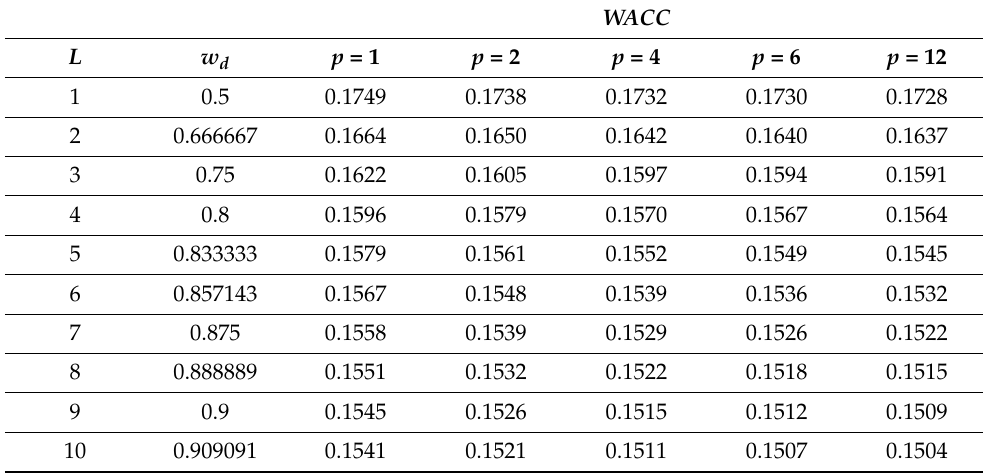
Table 2. Dependence of the weighted average cost of capital, WACC , on leverage level L at different frequency of payments of tax on profit p for three-year company.